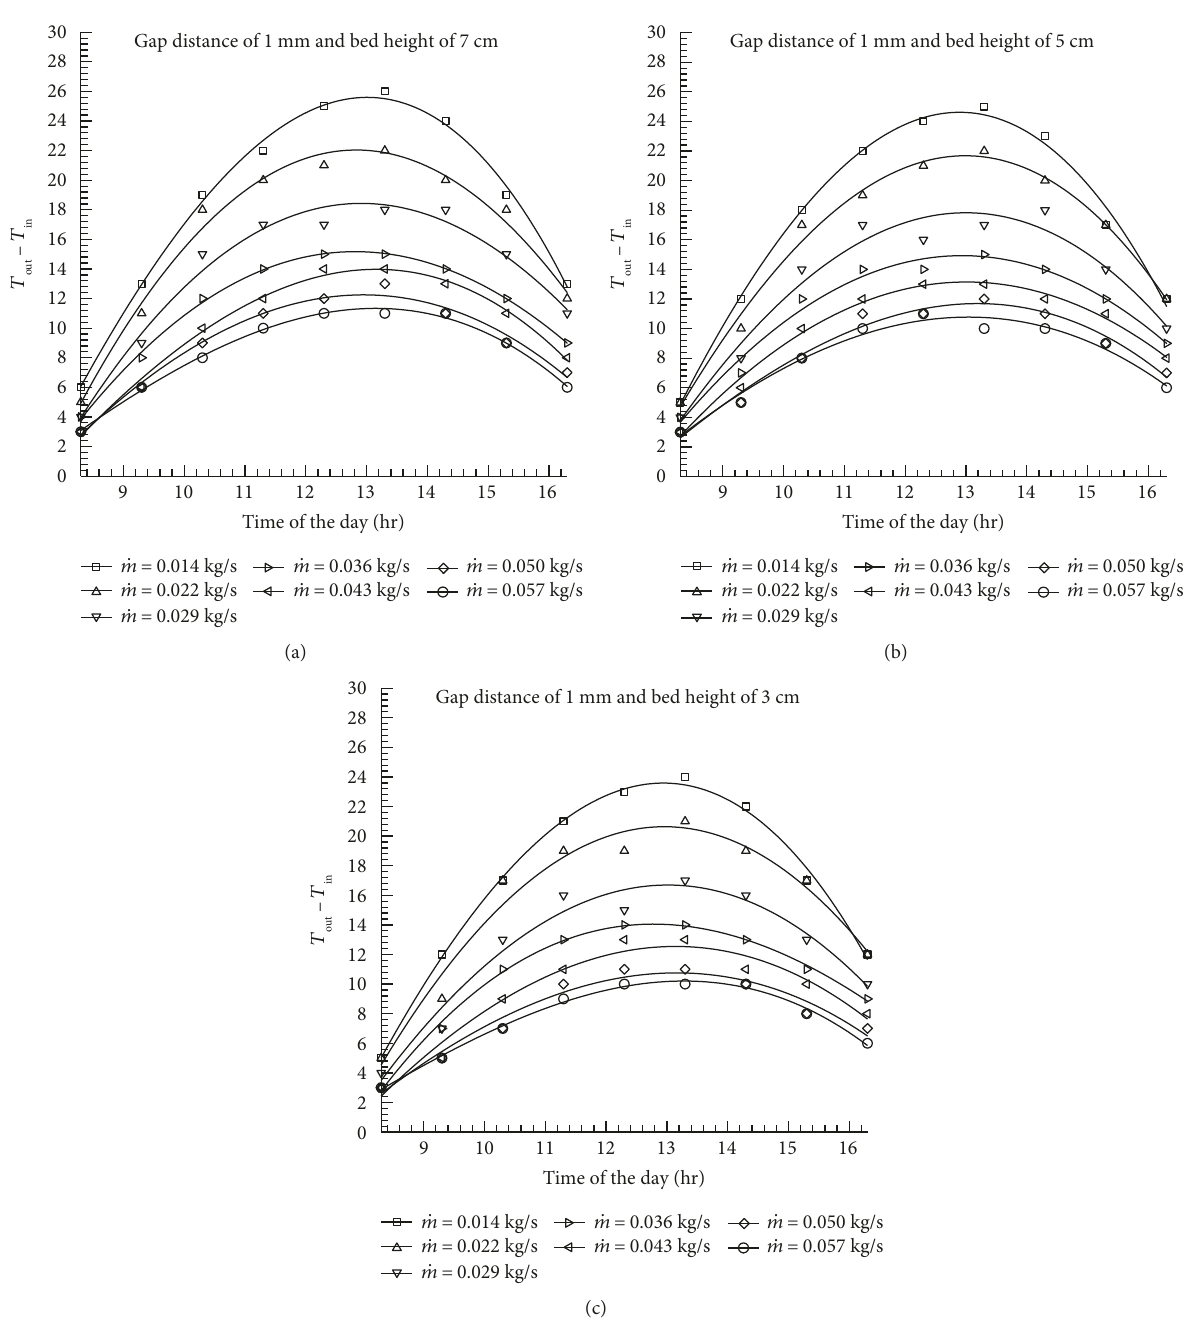
Figure 5: Temperature rise ( T (a) 7 cm, (b) 5 cm, and (c) 3